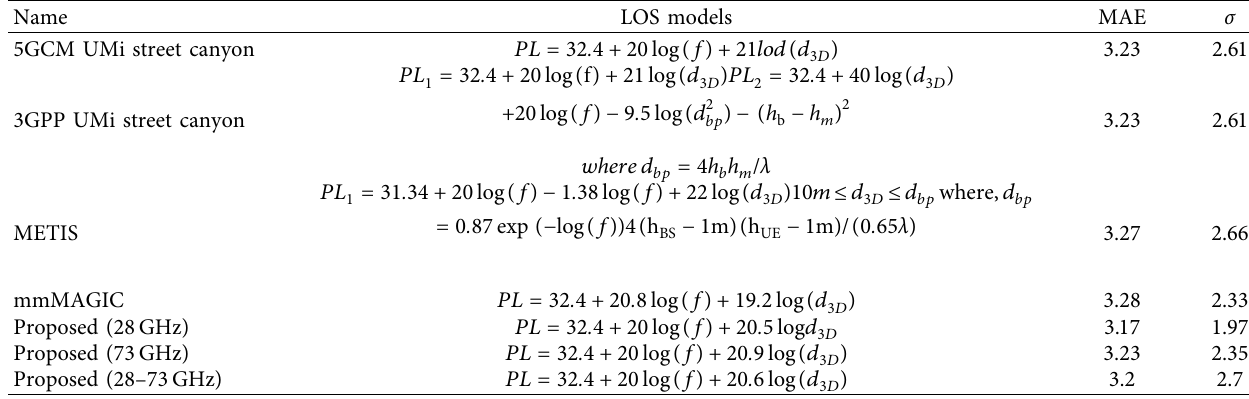
Table 5: Comparison of LOS path loss